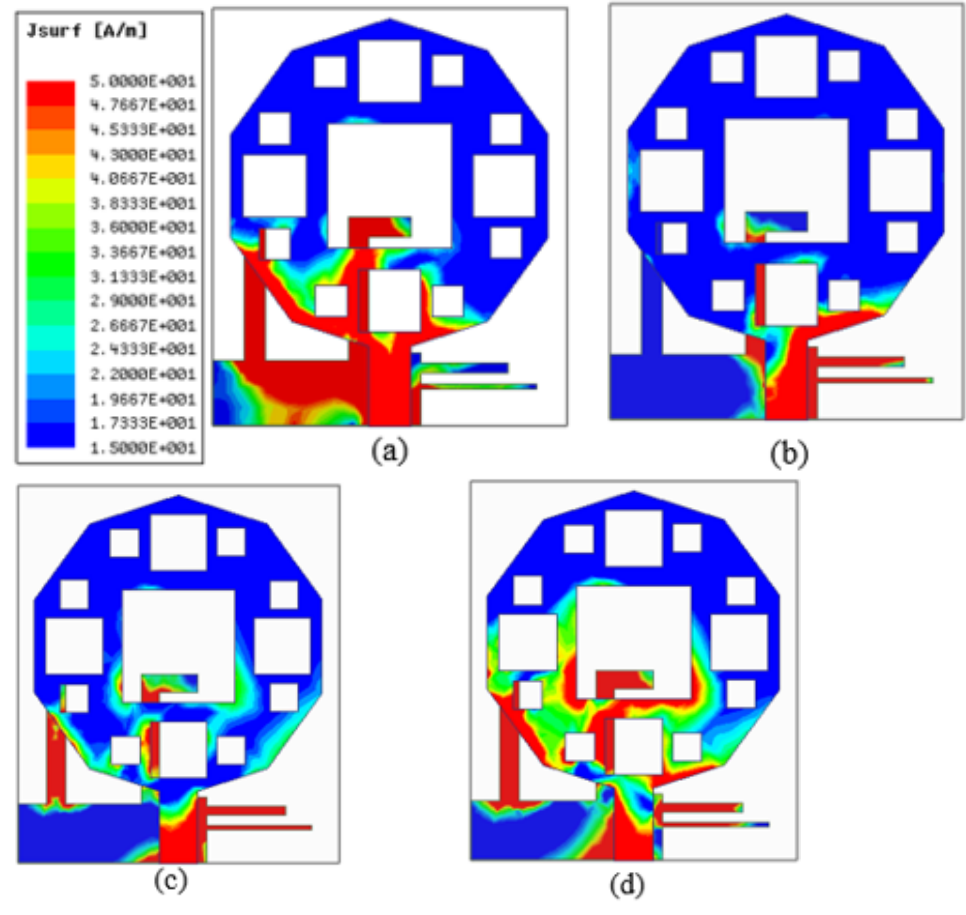
Figure 23. Surface current at ( a ) 4.35 GHz, ( b ) 5.9 GHz, ( c ) 8.7 GHz, ( d ) 9.7 GHz.